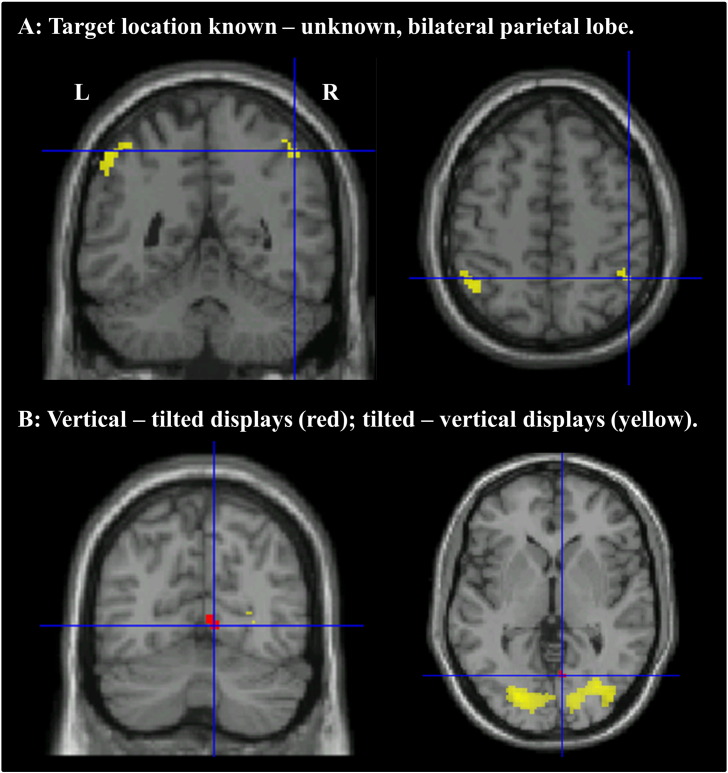
A. Parietal activation associated with knowing target location, crosshairs at 47, − 50, 52. B. Activation associated with viewing vertical versus tilted displays, crosshairs at 8, − 67, 0. p < 0.001 uncorrected, extent > 10 suprathreshold voxels.